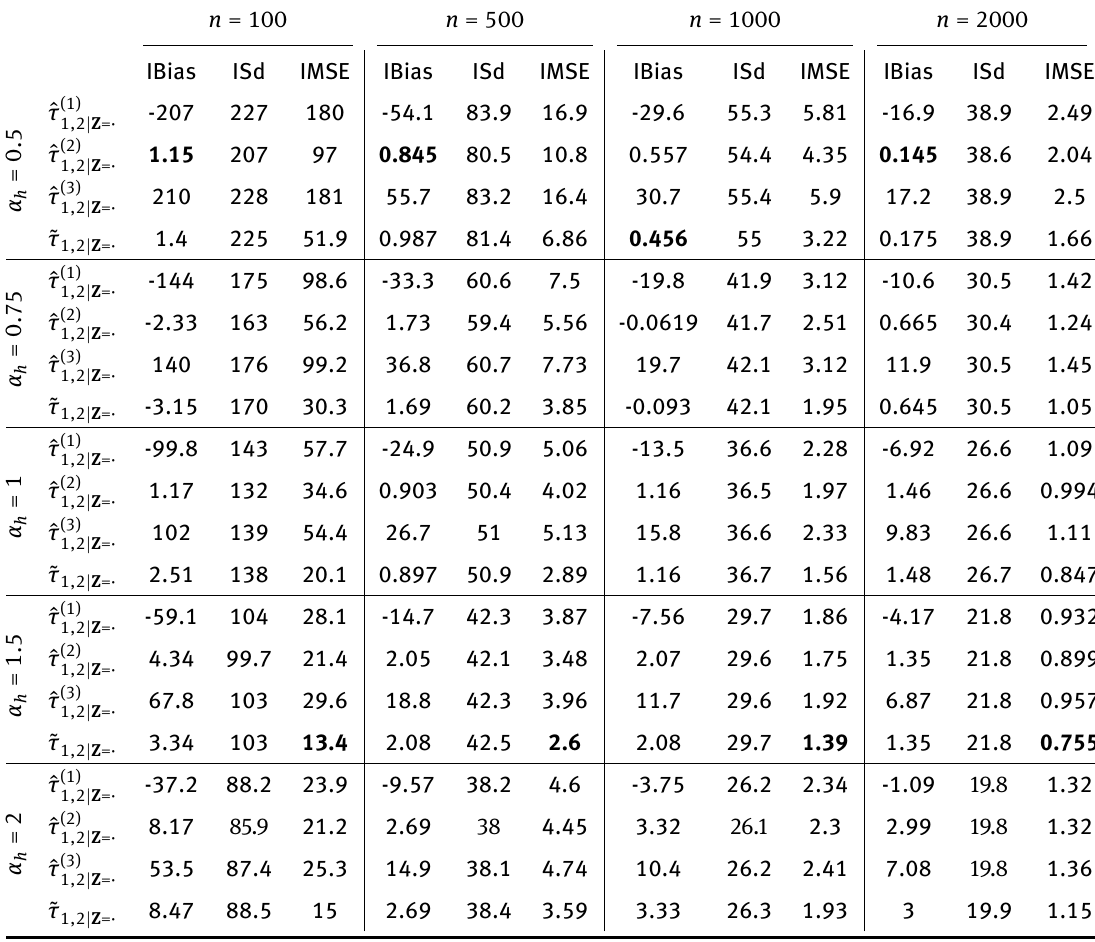
Table 2: Results of the simulation in Setting 2. All values have been multiplied by 1000. Bold values indicate optimal choices for the chosen measure of performance. These results are integrated measures of performance over the whole space Z ; the corresponding local measures of performance are displayed in Figures 3 and